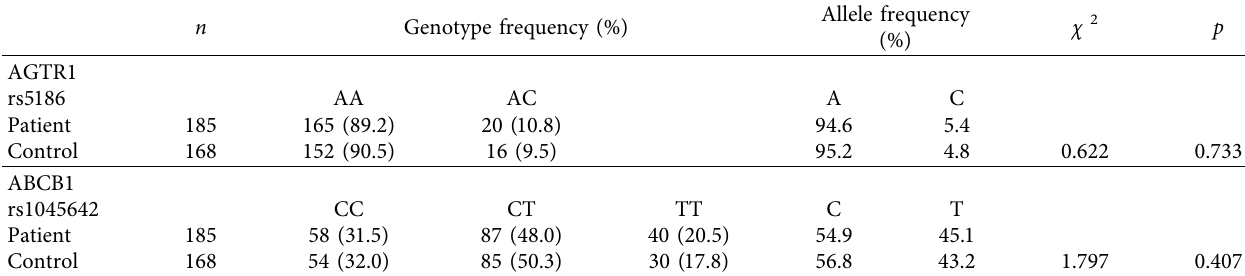
Table 2: Te genotype frequency distribution in patient, control, and published article groups showed no signifcant diference.